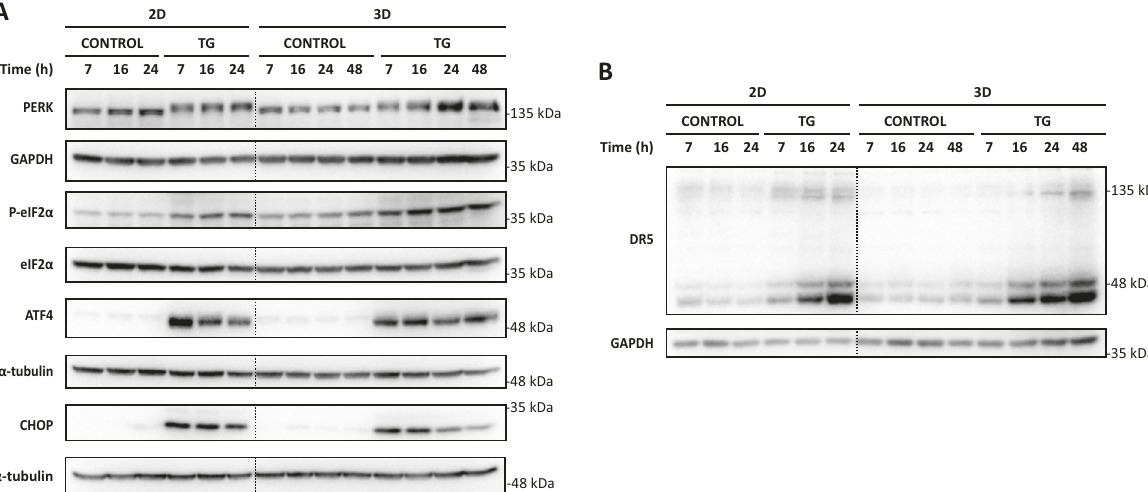
Fig. 5 PERK pathway activation upon ER stress in bidimensional cultures and multicellular tumor spheroids. HCT116 cells, in conventional 2D cultures or spheroids (3D) (10-days), were treated with TG (100 nM) for the indicated times. Activation of the PERK signaling pathway ( A ) and TRAIL-R2/DR5 protein levels ( B ) were assessed in whole-cell extracts by western blotting. α -tubulin or GAPDH were used as protein- loading